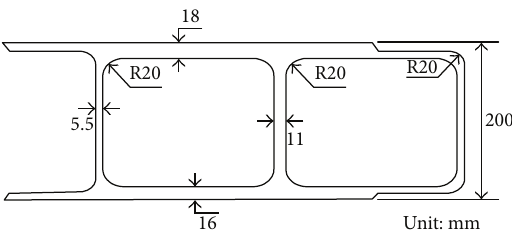
Figure 1: Shape of FRP bridge deck.